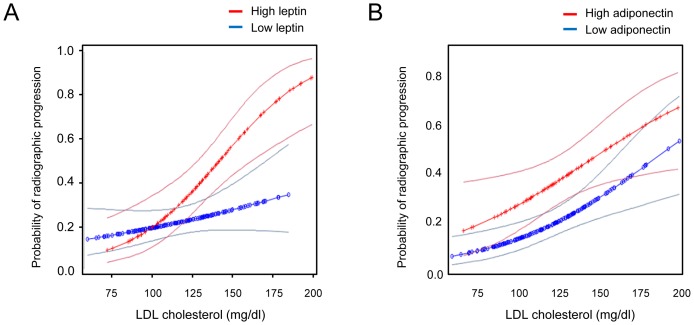
Effect of serum leptin levels on radiographic progression linked to LDL cholesterolemia.Adjusted cumulative probability plots for radiographic progression according to LDL cholesterol levels in patients with RA were stratified again by leptin levels (A) and adiponectin levels (B). In each panel, the upper cut-off value is represented by the red line (≧16.888 ng/ml for leptin and ≧1.682 µg/ml for adiponectin), and the lower cut-off value is the blue line (<16.888 ng/ml for leptin and <1.682 µg/ml for adiponectin). The upper and lower 95% confidence limits are depicted by the grey lines surrounding the average probability plot.